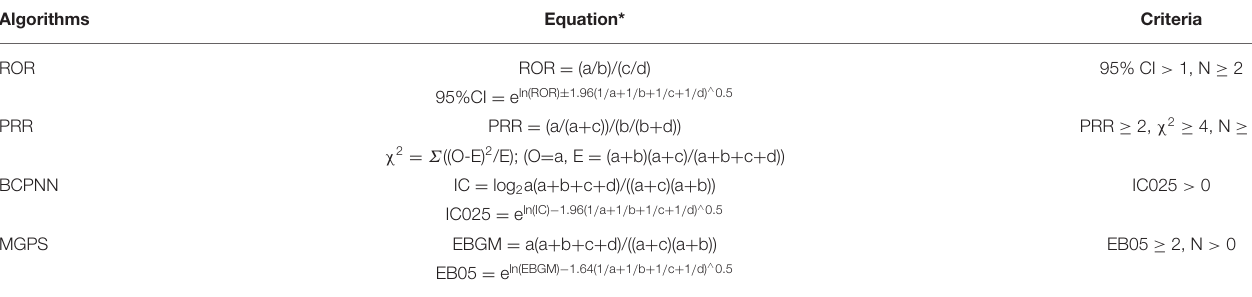
TABLE 1 | Summary of major algorithms used for signal detection. Algorithms Equation* Criteria